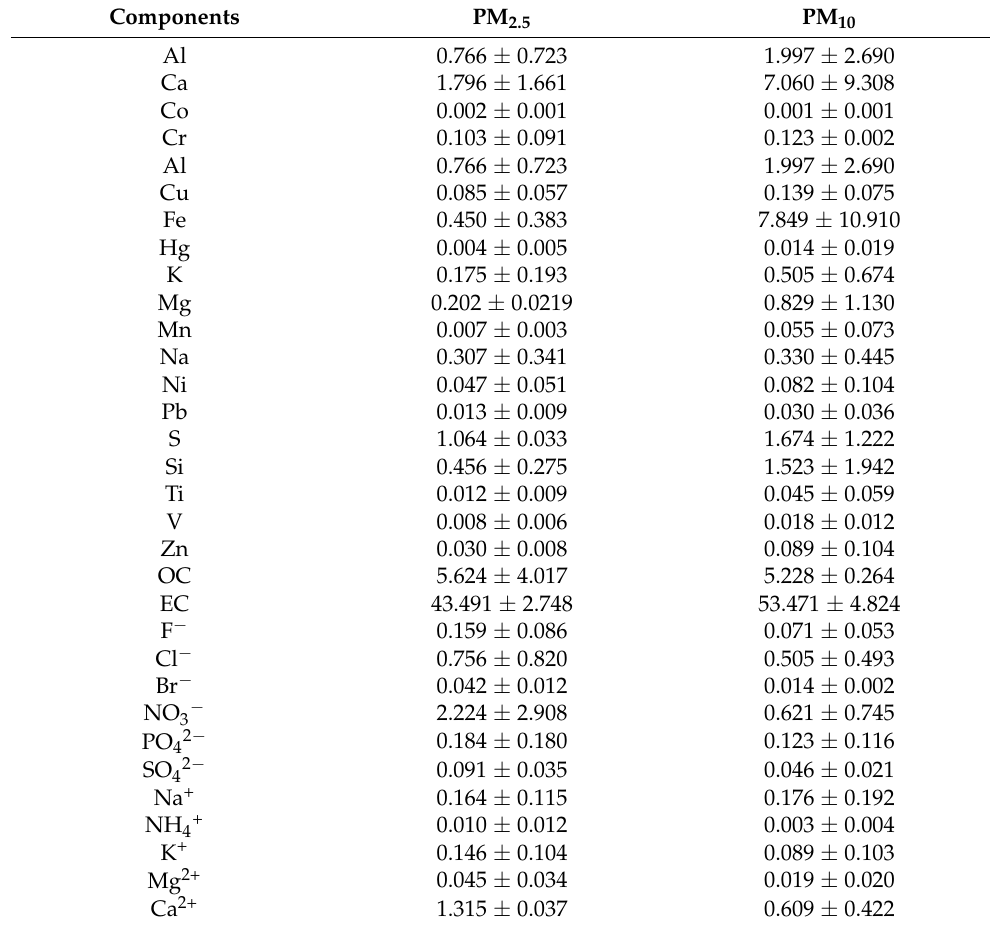
Table 2. The source profiles of PM 10 and PM 2.5 from carbon plant